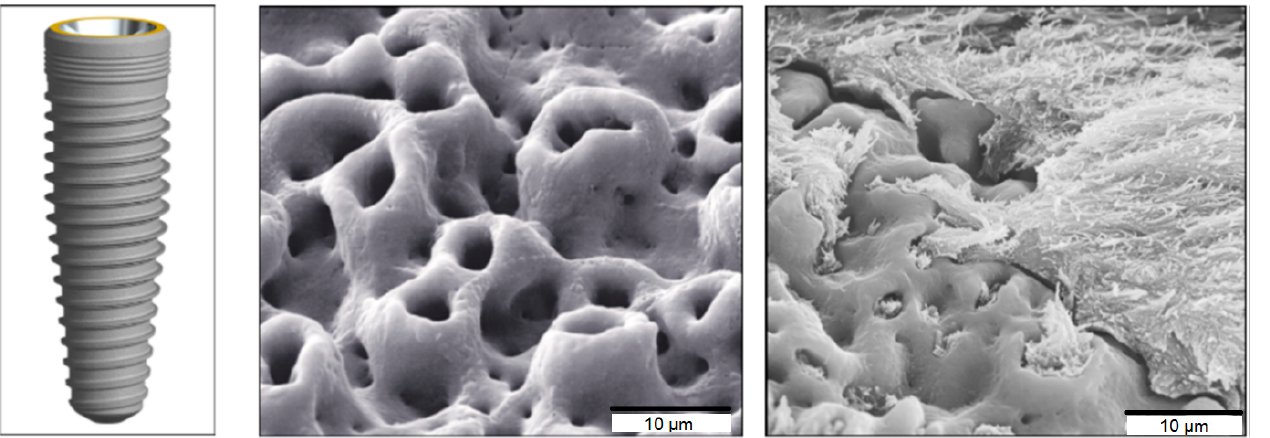
Figure 8. Surface features and scanning electron micrographs of a TiUnite dental implant surface. (Reprinted from [38], license CC BY 4.0.)